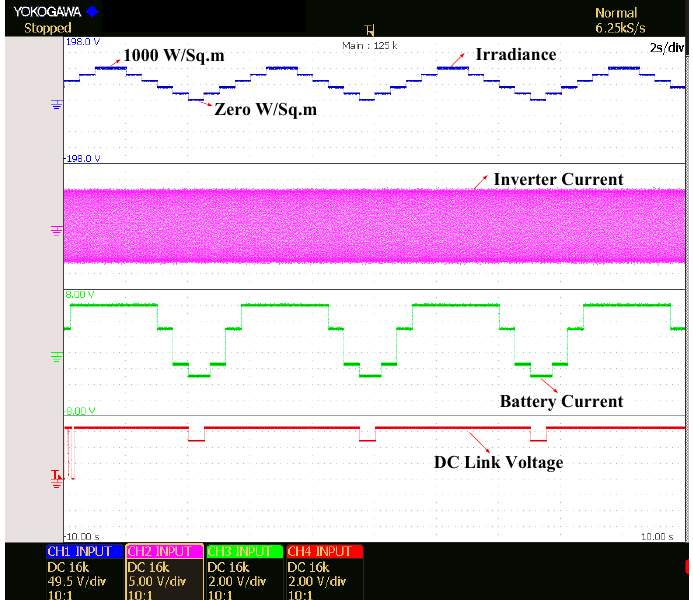
Figure 14. Change in battery current, inverter current and DC link voltages with a change in irradiance in standalone mode operation.